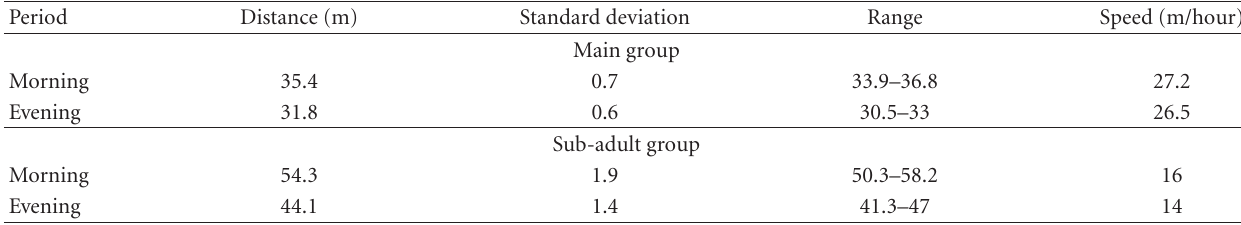
Table 2: Daily movement of main and subadult group of P. c. chrysomelas.